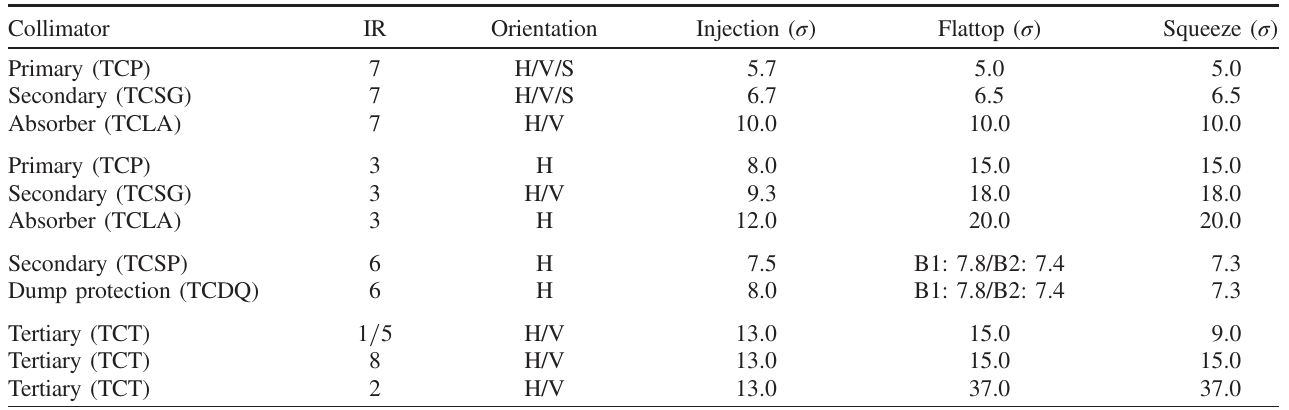
TABLE I. List of 2018 settings for collimation. The settings are expressed in beam size values, assuming a nominal beam emittance of 3 . 5 μ m.